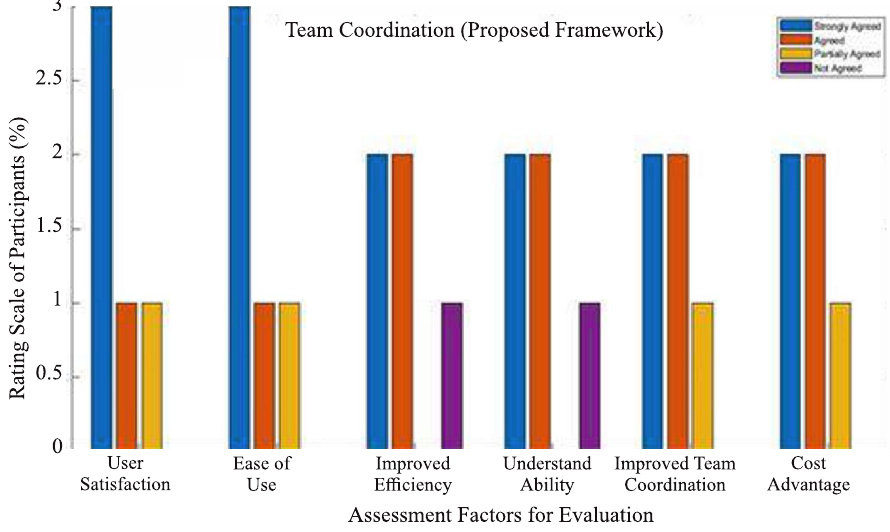
FIG. 6. RESULTS OF TEAM COORDINATION (PROPOSED FRAMEWORK)